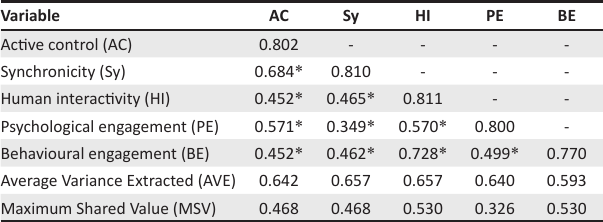
TABLE 2: Correlation and validity